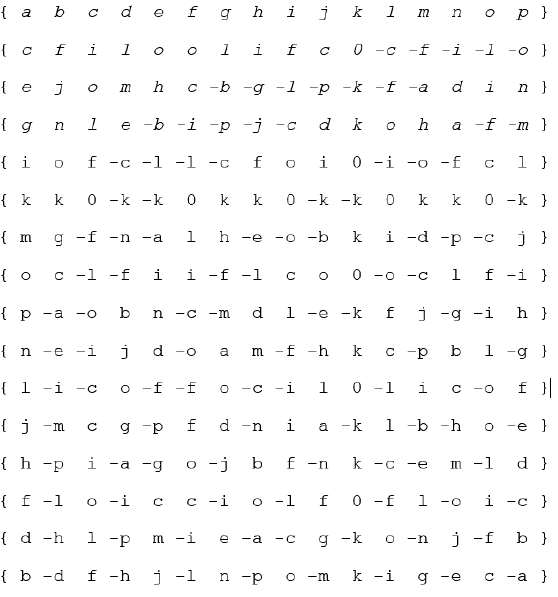
Figure 17. Illustration of 16 − point DST − 7 kernel unique integer numbers Figure 17 . Illustration of 16 − point DST − 7 kernel unique integer numbers [28].